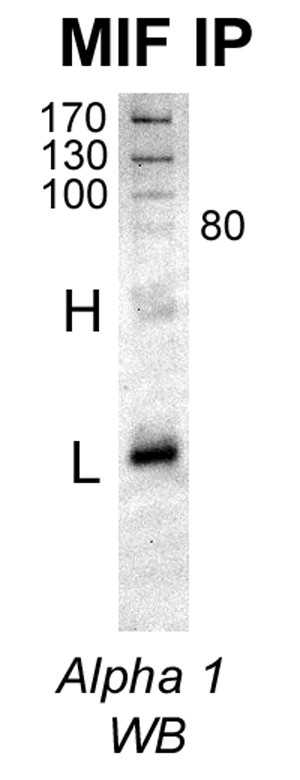
Co-immunoprecipitation of MIF/A1-I3 from bladder homogenates. Co-immunoprecipitation of bladder homogenates followed by A1-I3 WB showed that MIF antisera was able to pull-down MIF/A1-I3 complexes with apparent molecular weights of 170, 130, 100 and 80 kDa. H, L labels refer to heavy chain and light chain of IgG, respectively. A1-I3 WB was performed under reducing conditions.